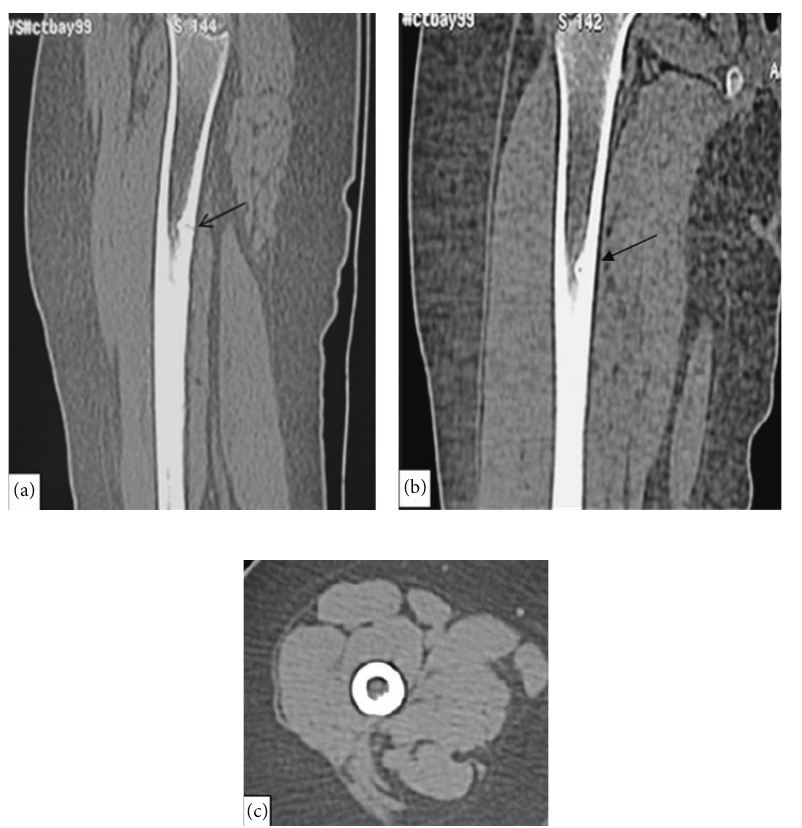
Figure 2: Sagittal (a), coronal (b), and axial (c) reconstructed CT images show a linear defect (arrow) in the medial cortex of the right femur with sclerotic